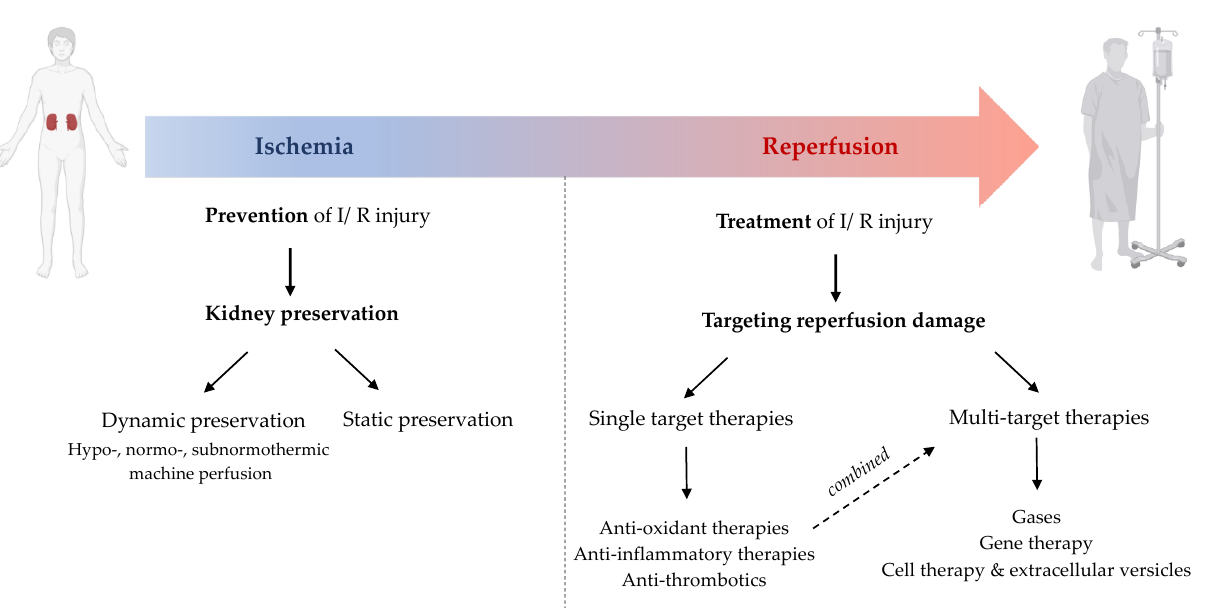
Figure 4. Strategies for kidney graft protection during transplantation.